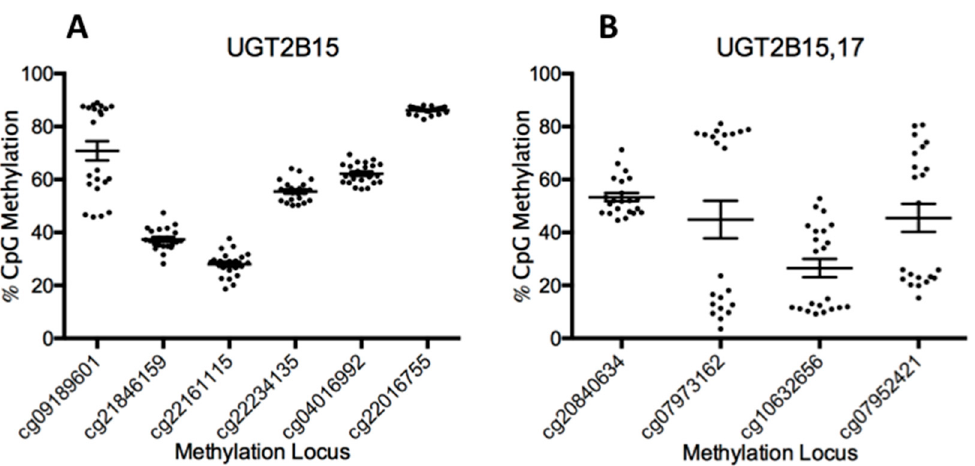
Figure 1. Grouped data showing the methylation beta values ( y -axis) for each sample at a particular Cytosine-Guanine (CG) locus ( x -axis) UGT2B15 ( A ) and UGT2B15/17 ( B ). Because UGT2B15/2B17 were formed by a gene duplication event, they also share common loci. Values above 70% are generally considered to be fully methylated on both strands and values below 30% are typically un-methylated on both strands with intermediate values indicating that only one of the two strands are methylated.